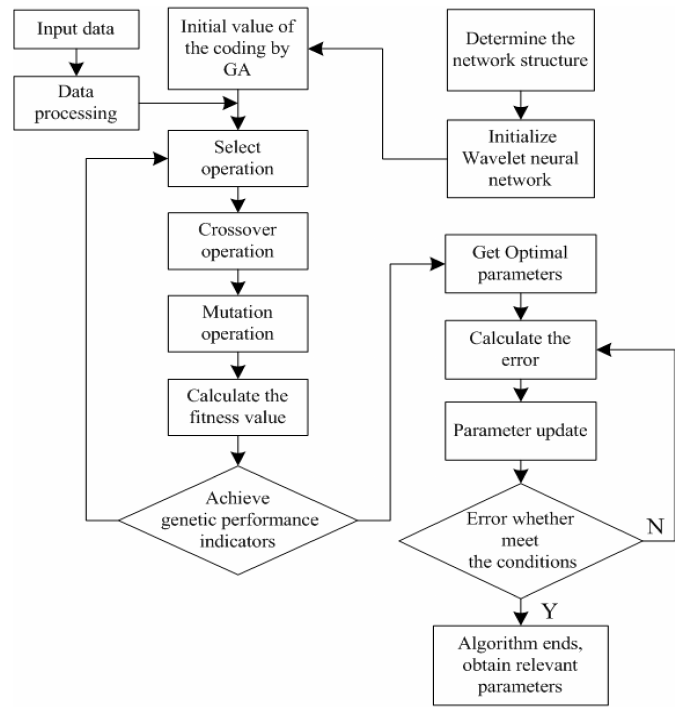
Figure 5. Flowchart of the GA-WNN compensation